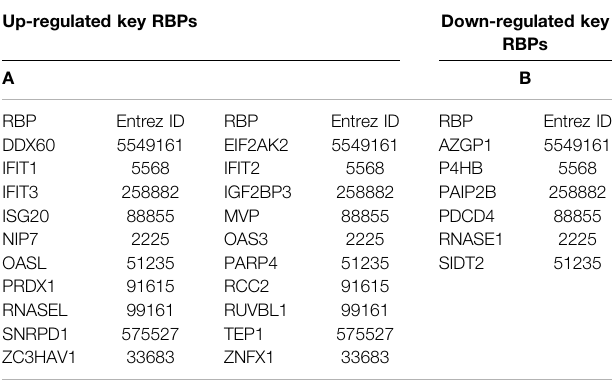
TABLE 2 | Information of the DE-RBPs used for target RNA identi fi cation. Hub RBPs along with the top-altered RBPs are included in this group. These set of RBPs are presented in the table as (A) upregulated RBPs and B) downregulated RBPs. Up-regulated key